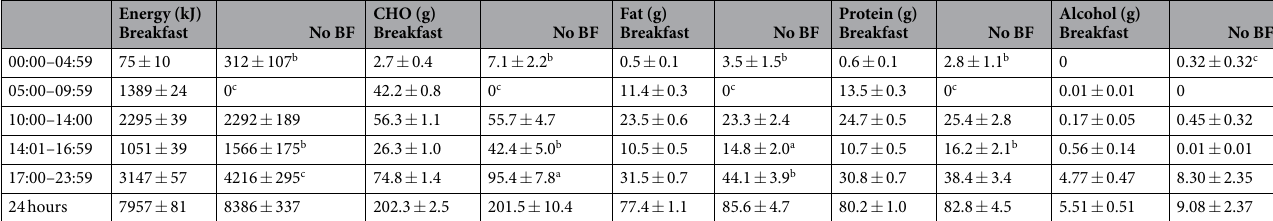
Table 4. Energy and macronutrient intakes at different times of day divided by breakfast consumption status.